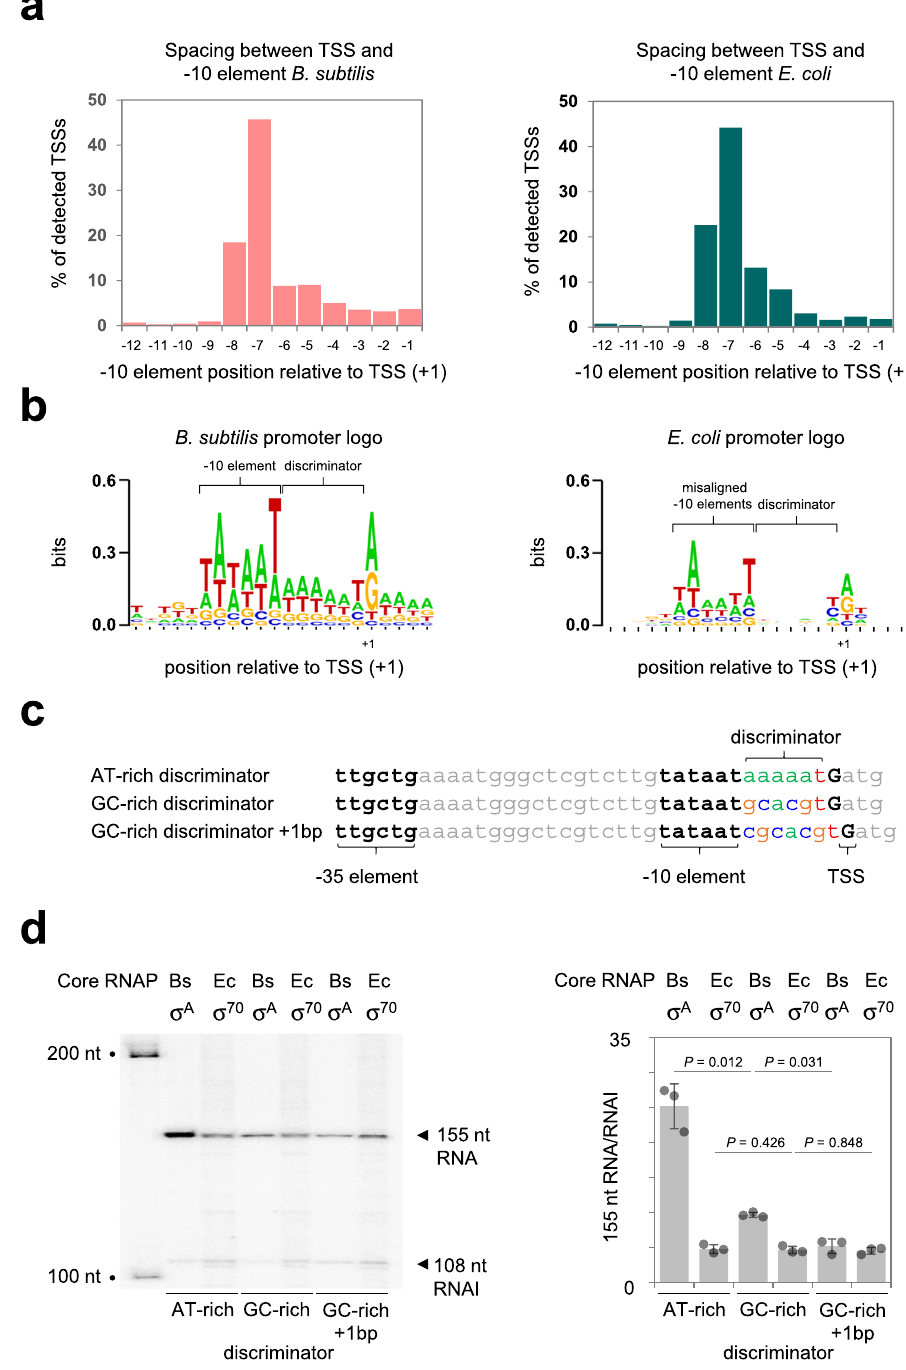
Fig. 3 E. coli housekeeping RNA polymerase better tolerates promoter sequence variation. a Positioning of promoter − 10 elements and transcription start sites in E. coli and B. subtilis . The bar charts show the percentage of promoter − 10 elements located at indicated distances upstream of transcription start sites (TSSs, + 1) identi fi ed by cappable-seq for E. coli and B. subtilis . b The panel shows DNA sequence logos generated by aligning nucleic acid regions upstream of B. subtilis (left) or E. coli (right) transcription start sites. The more variable spacing between transcription start sites and promoter − 10 elements in E. coli generates a motif that misrepresents the consensus − 10 element sequence (5 ′ -TATAAT-3 ′ ). There is no overall sequence preference for the promoter discriminator region in E. coli whilst an AT-rich sequence is common in B. subtilis . c DNA sequences of the B. subtilis veg promoter and derivatives with either an AT-rich or GC-rich discriminator sequence. d Results of in vitro transcription assays using DNA templates containing one of the promoter sequences shown in ( c ). Experiments were done with either the B. subtilis (Bs) σ A , or E. coli (Ec) σ 70 , RNA polymerase holoenzyme (0.5 μ M). The 155 nucleotide (nt) transcript is generated from the cloned promoter and the 108 nt RNAI transcript is derived from the plasmid replication origin. The gel image shows a representative result and the bar chart shows a quanti fi cation of three independent experiments. Error bars show S.D. and the centre of the error bars is the mean. P was calculated using a two-tailed student ’ s T